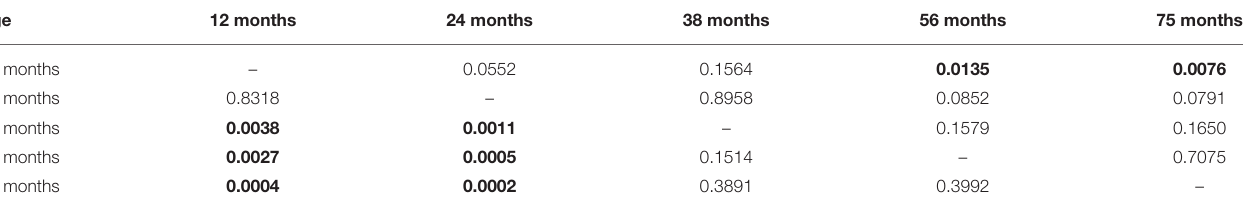
TABLE 1 | One-way permutational multivariate ANOVA (PERMANOVA) test of age-related cognitive performance for short-term memory (values below diagonal line) and long-term memory (values above diagonal